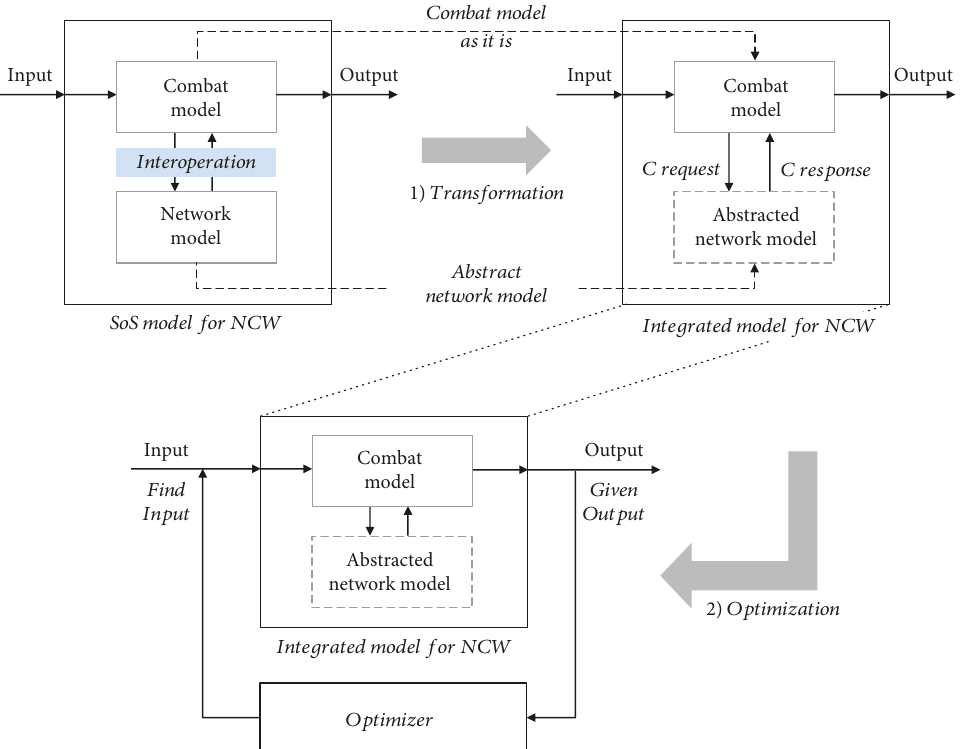
Figure 5: Overall procedure of the proposed